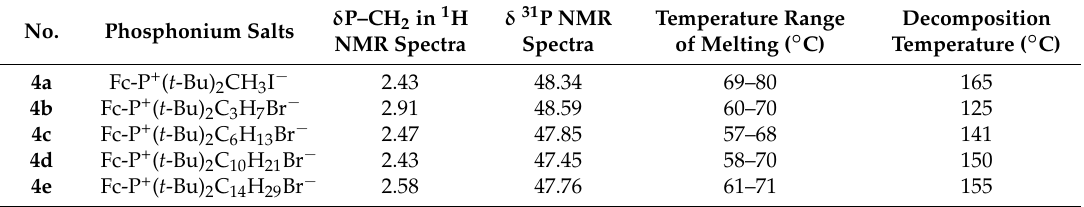
Table 2. 1 H and 31 P chemical shifts of Fc-containing phosphonium salts 4a – e a .